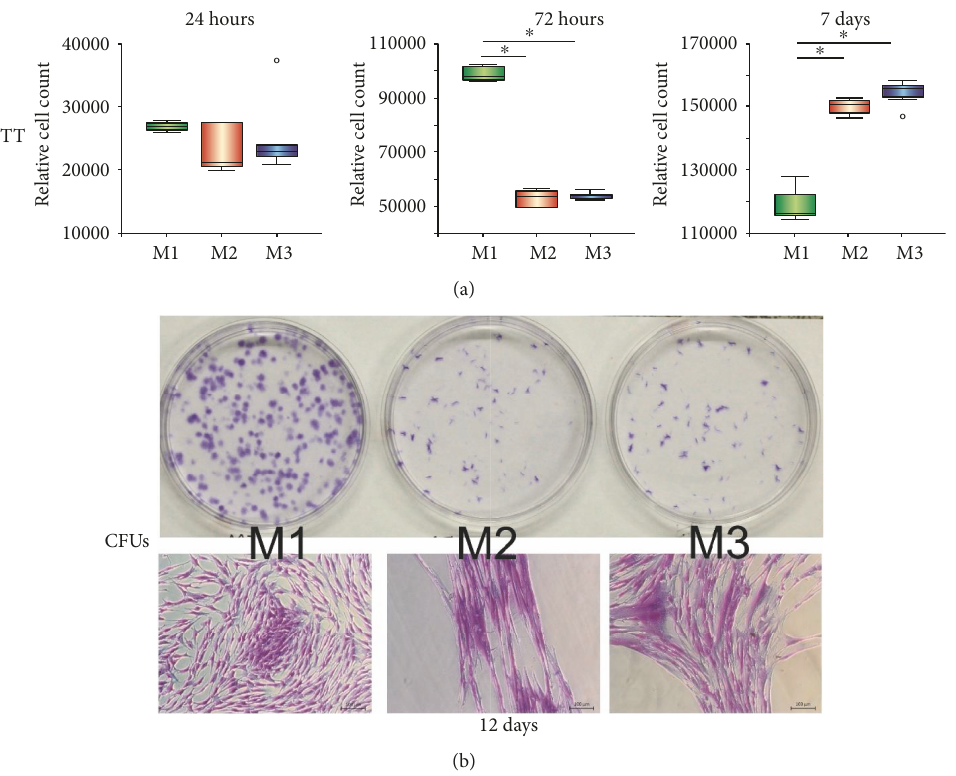
Figure 2: Cell proliferation and colony-forming characteristics of G-MSCs under in fl ammatory environment. (a) MTT results of G-MSC proliferation in the three groups at day 1, 3, and 7 days. Signi fi cant di ff erences between groups are marked with an asterisk ( ∗ p < 0 05 ; Dunn ’ s test). (b) Crystal violet staining results for colony-forming unit (CFU) assay and microscopic appearance of G-MSCs cultured with a basic medium (M1), in fl ammatory medium (M2), and anti-in fl ammatory treatment medium (M3) after 12